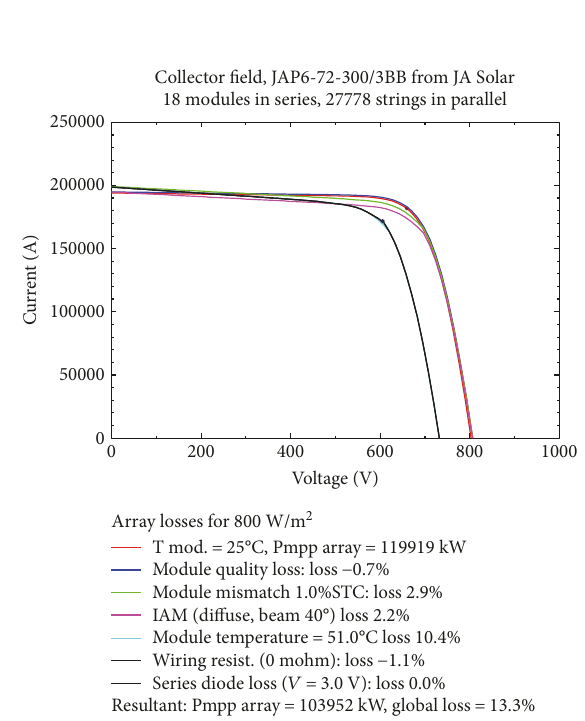
Figure 4: Simulation results of PV array behavior for each loss e ff ect of JA Solar